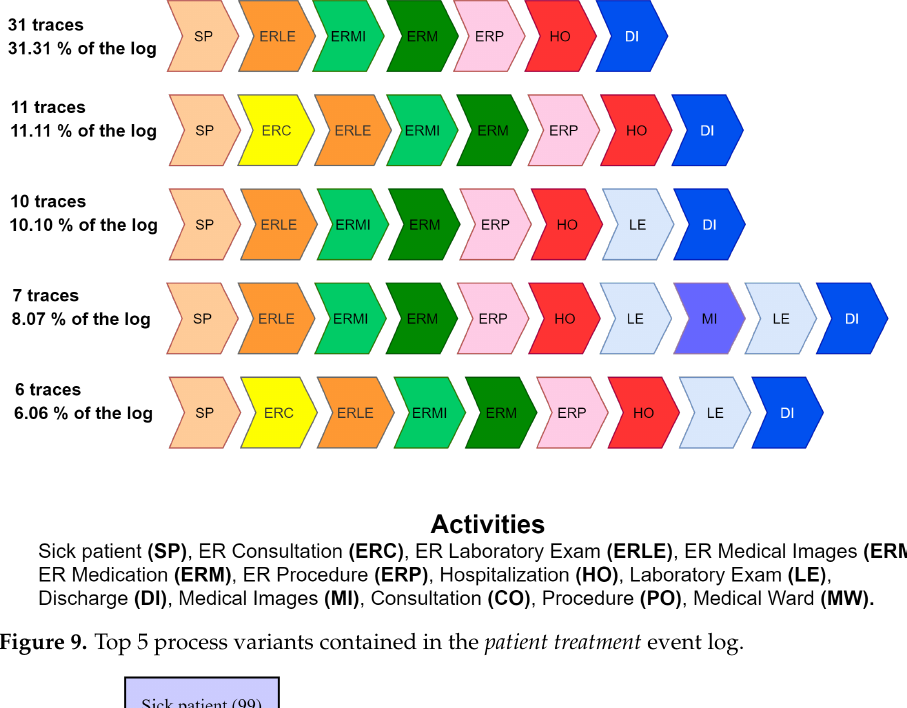
Figure 9. Top 5 process variants contained in the patient treatment event log.